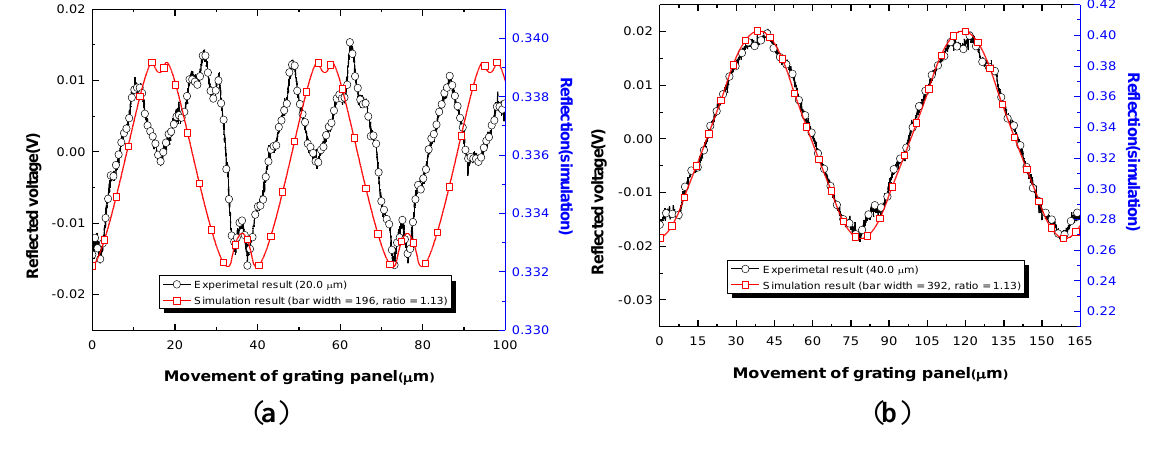
of 20.0 µm; ( b ) RGP with b 1 of 40.0 µm; ( c ) RGP with b 1 of 67.5 µm; ( d ) RGP with b 1 of 90.0